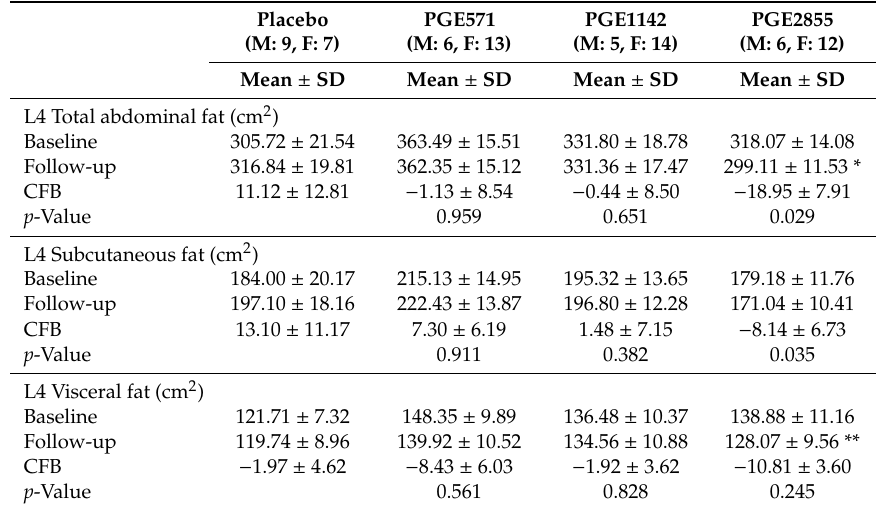
Table 5. E ff ect of PGE supplementation for 12 weeks on change of abdominal fat area assessed by computed tomography (CT) in subjects with overweight or